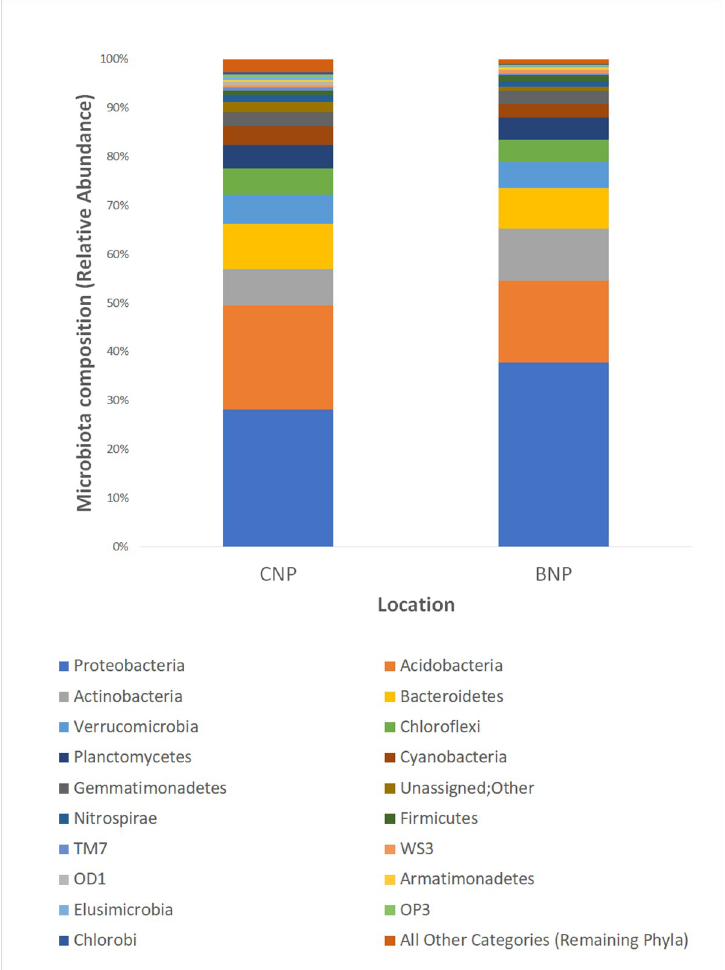
Fig 4. Soil microbiota biodiversity examined at two TAL sites. Relative abundance of microbial phyla detected in soil samples ( n = 8) collected at CNP ( n = 3) and BNP ( n =